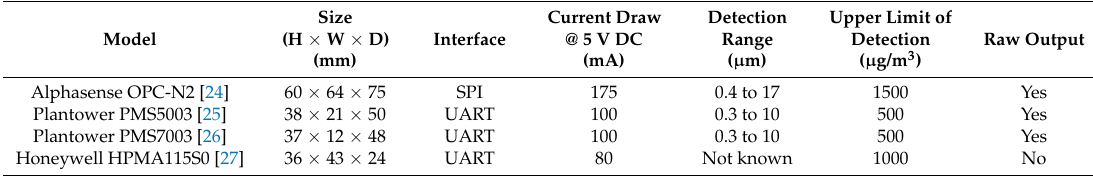
Table 1. Main characteristics of the fan assisted Particulate Matter (PM) sensors used for deployment in Version 1 of the pilot Air Quality (AQ) Internet of Things (IoT)